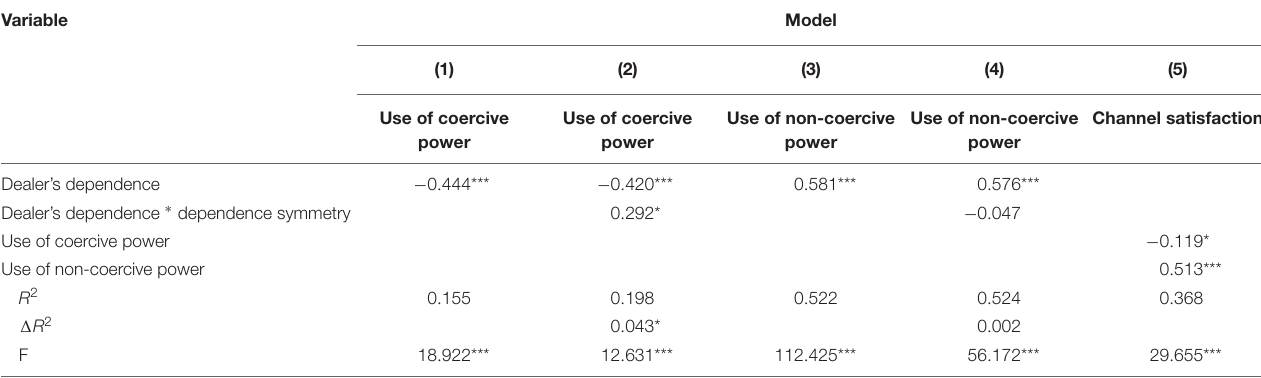
TABLE 3 | Statistical results of multiple regression.